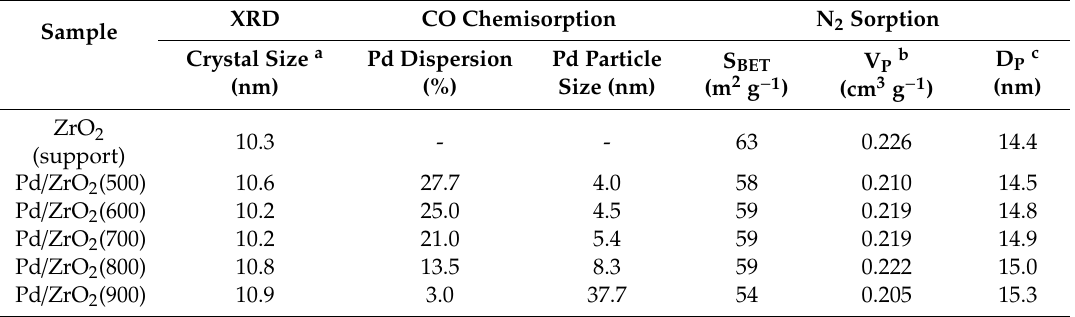
Table 1. Physicochemical properties of the ZrO 2 support and the Pd / ZrO 2 (x) catalysts, as determined by XRD, CO chemisorption, and N 2 sorption